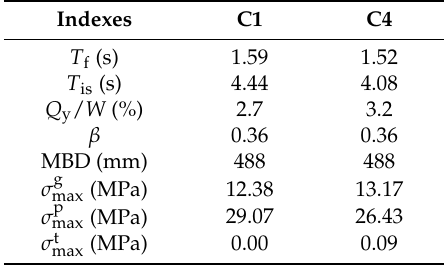
Table 2. Critical design parameters and indexes of prototype